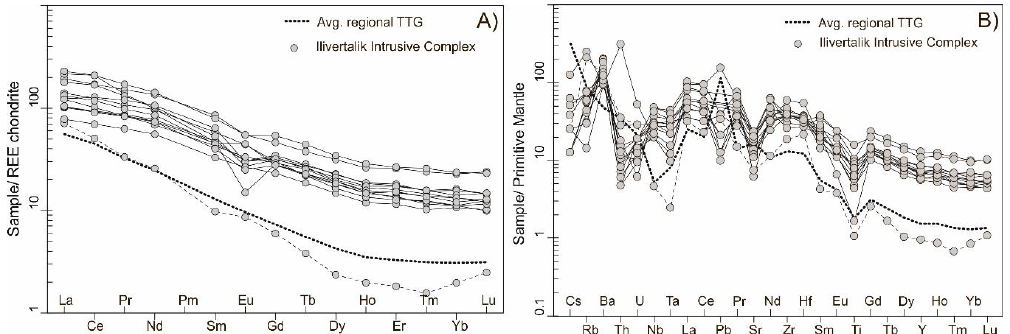
Figure 5. Normalized trace element spider diagrams. The IIC samples divide into two groups, the main group includes diorites and the main part of the granites and outlier samples are indicated with stippled lines and are considered to have a different petrogenesis. ( A ) Chondrite-normalized REE spider diagram [37]. ( B ) Primitive mantle normalized trace element spider diagram including REE, HFSE and LILE [38]. Average regional TTG compositions are shown for reference [39]. The sample with striking different REE patterns (sample 468698, stippled line in Figure 5A,B) display steeper REE pattern, with low HREE contents and are the most silica-rich sample with La/Yb C = 7.1 and slightly concave up HREE (Figure 5A). The sample display negative Ti, Nb and Ta